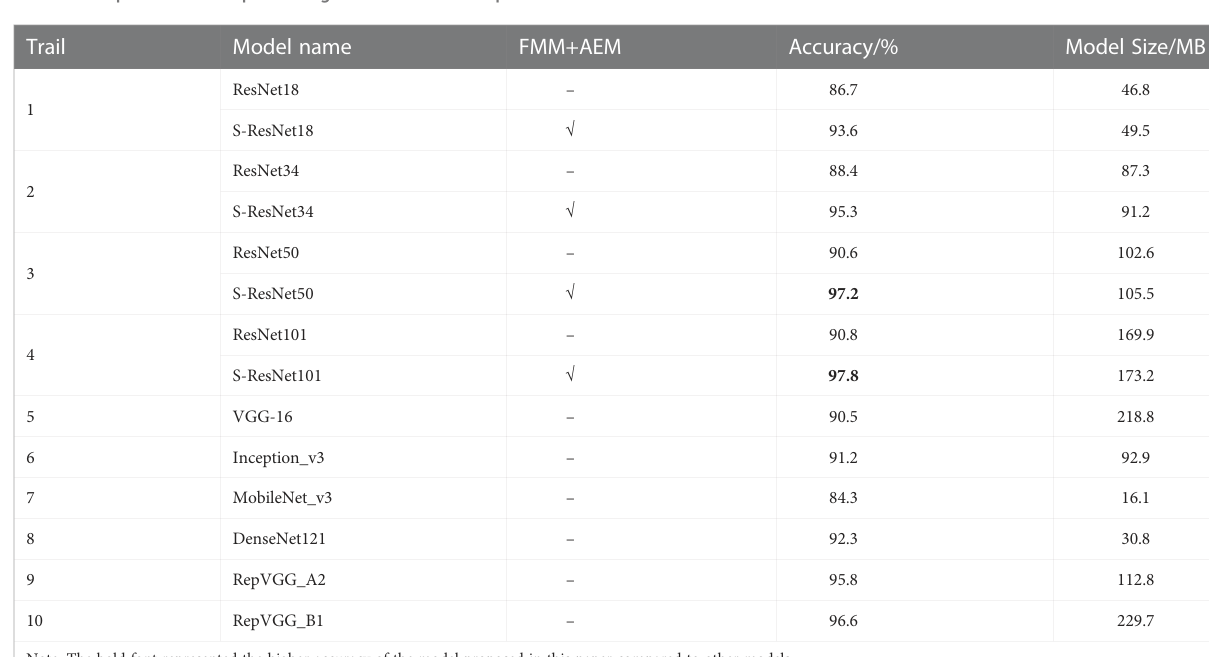
TABLE 5 Impact of feature processing modules on model performance.